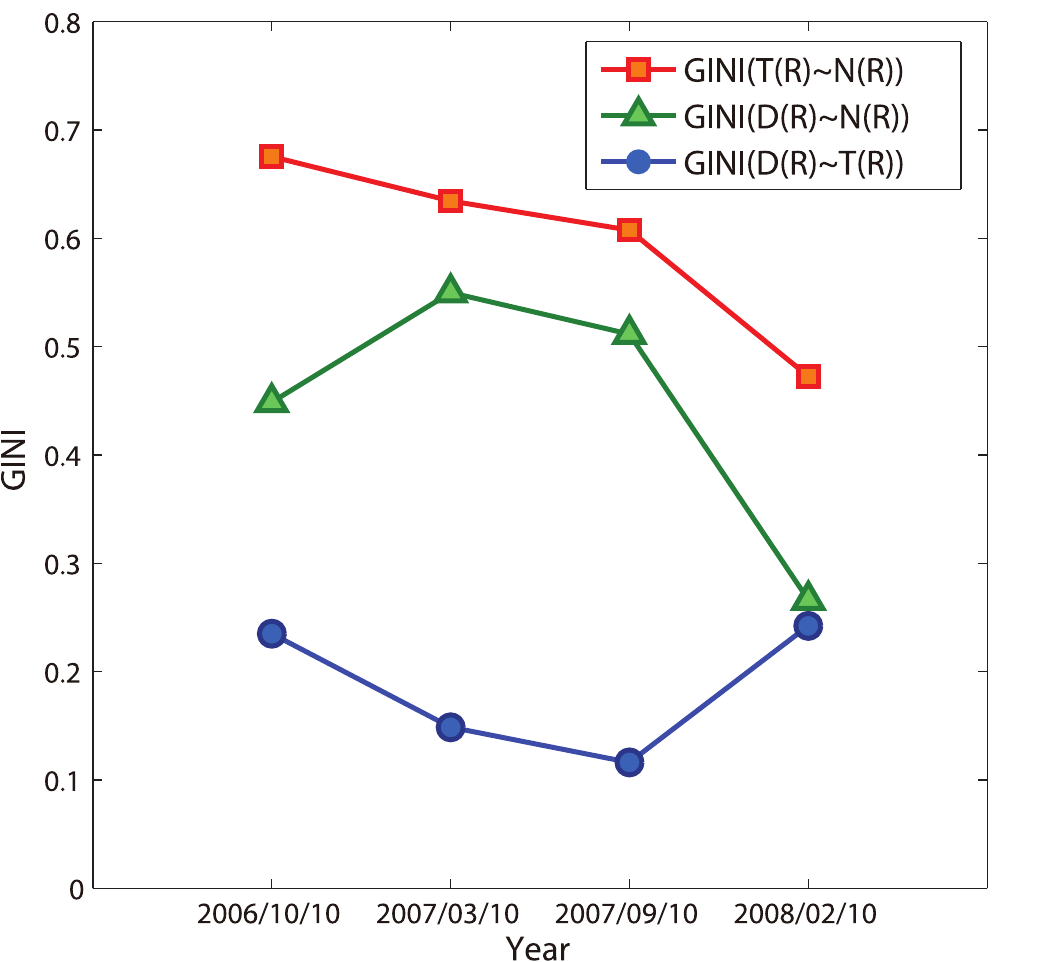
Fig 10. The GINI-liked coefficients ’ variation during October 10,2006 and February